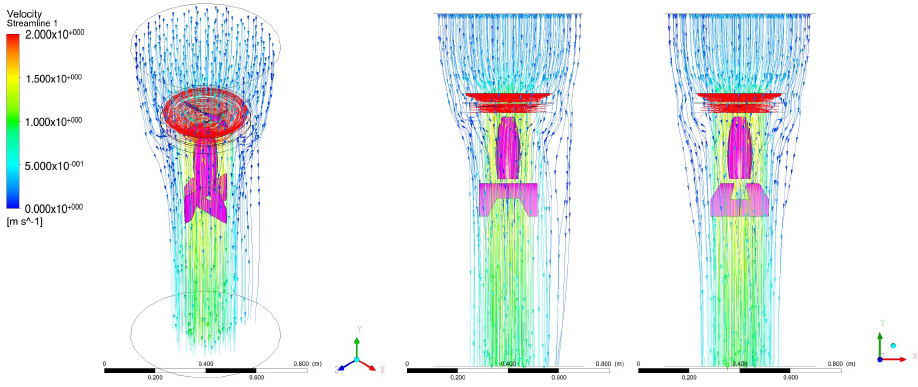
Figure 8. MCR UAV v3.0 scaled streamlines.